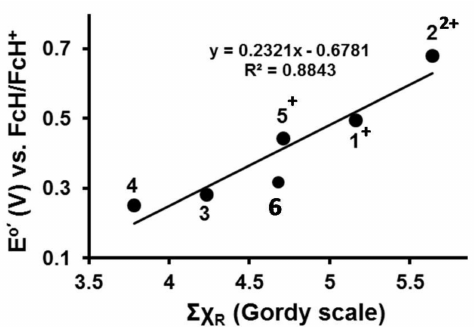
Figure 4. Linear relationship between the sum of the group electronegativities, Σ χ R , and the iridium-based redox potentials, E ◦(cid:48) , for compounds 1 – 6